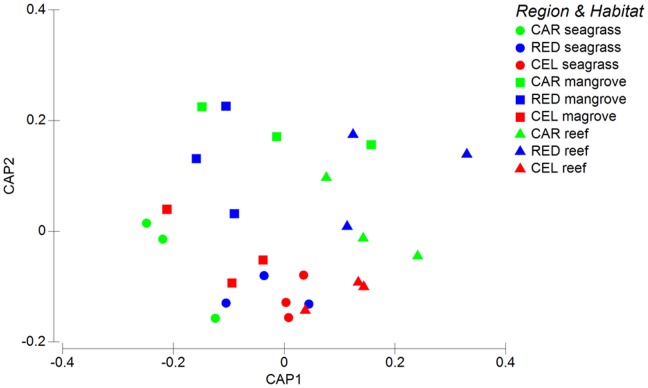
Bi-plots after the canonical analysis of principal coordinates illustrating differences in the composition of total meiofaunal taxa in the sediments of the investigated oceanic regions and habitats.CAR = Caribbean Sea (green); CEL = Celebes Sea (red); RED = Red Sea (blue).